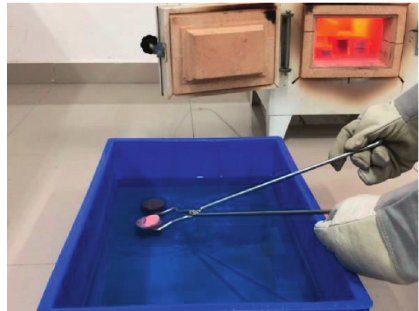
Figure 1: Water cooling treatment for heated sandstone.